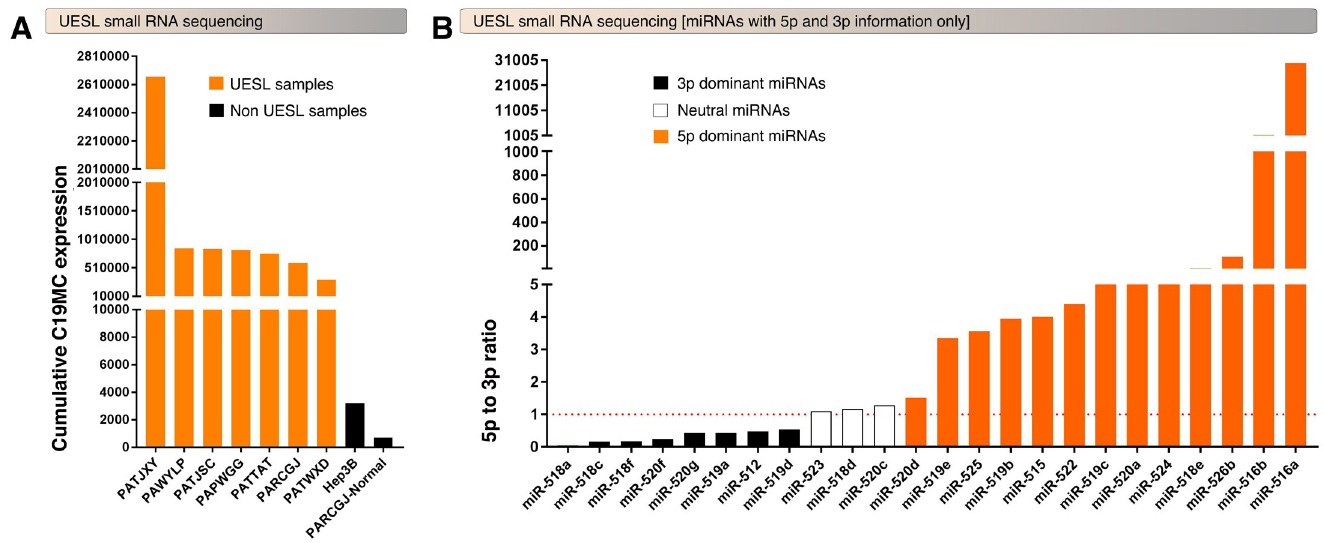
Fig 3. UESL tumors hyperexpress C19MC miRNAs with selective upregulation of 5p or 3p mature miRNAs. A, Small RNA-seq showing overexpression of C19MC miRNAs in UESL tumors compared to normal liver sample or Hep3B cell line. The bar graphs represent the cumulative expression of all 46 C19MC miRNAs (5p and 3p). B, 24 C19MC miRNAs that have 5p and 3p mature miRNA information in UESL tumors display miRNA-specific selective 5p vs. 3p expressional